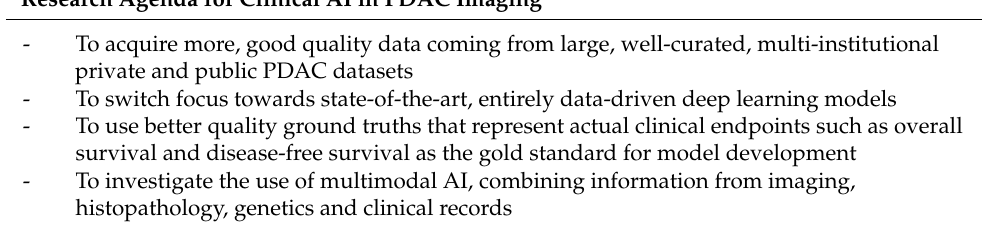
Table 5. Overview of the main topics for future clinical AI research in PDAC imaging. Research Agenda for Clinical AI in PDAC Imaging